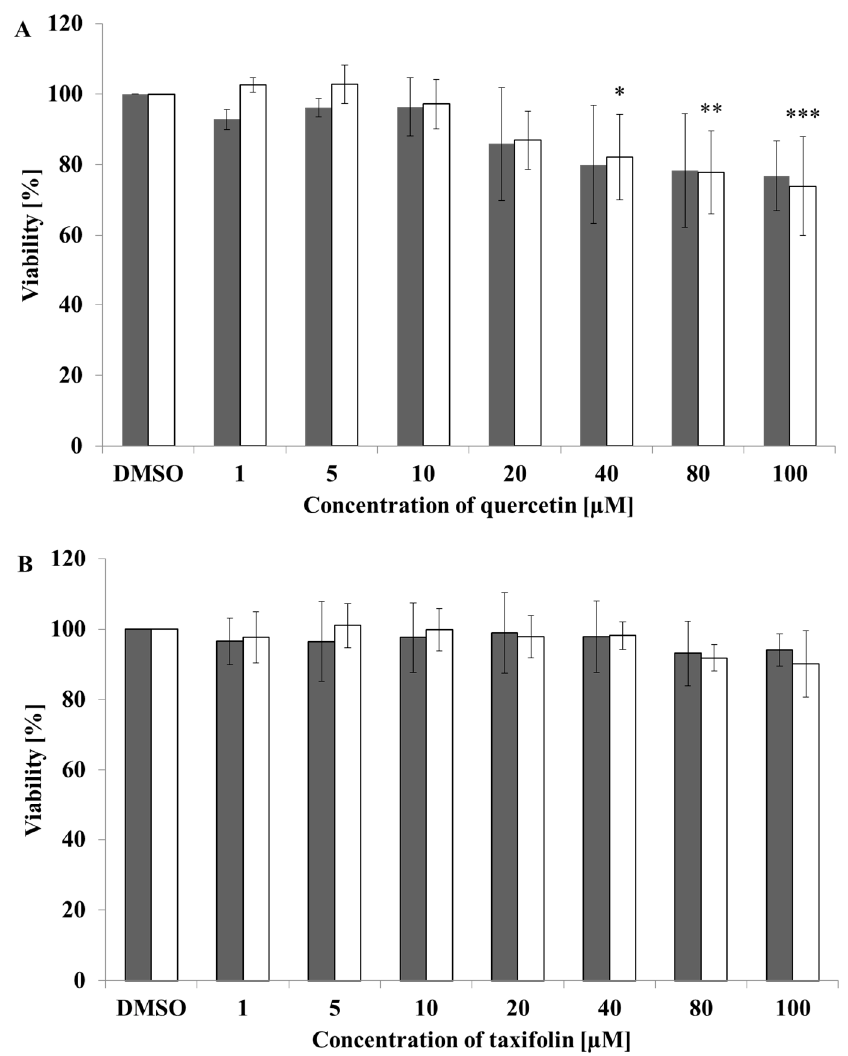
Figure 1. Cytotoxicity of tested compounds on Hep G2 cells evaluated with MTT and Neutral red assays. Panel ( A ) represents cytotoxicity of quercetin and panel ( B ) cytotoxicity of taxifolin evaluated with MTT/Neutral red assay that are shown as filled bars/empty bars, respectively. Each bar represents mean ± SD of three independent experiments. Cells were incubated with tested compounds for 24 h; in each experiment triplicate measurements were performed. * p < 0.05(** p < 0.01/*** p < 0.001) versus negative control.